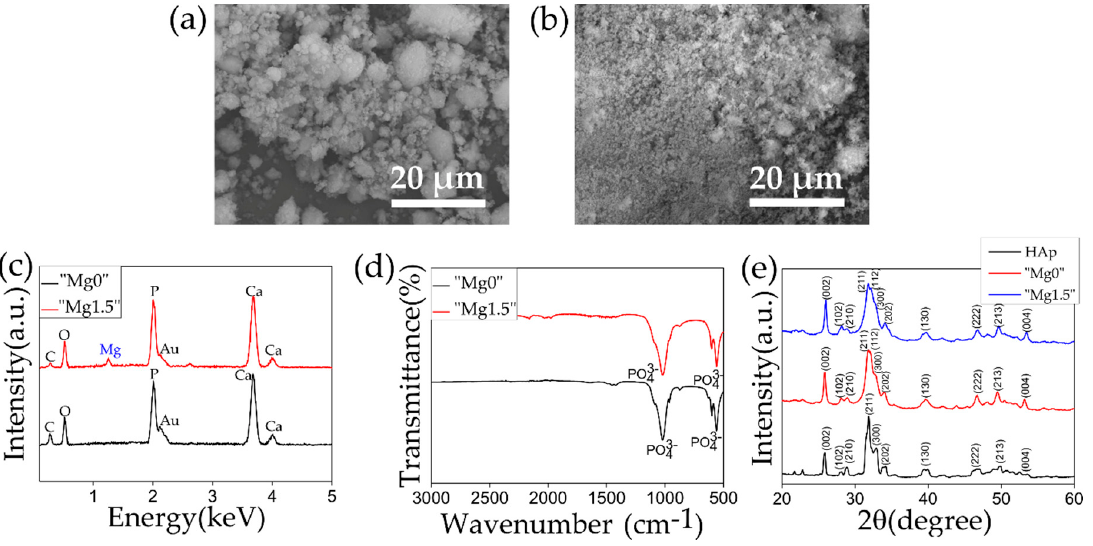
Figure 2. SEM images of ( a ) “Mg0” and ( b ) “Mg1.5” particles. ( c ) EDX and ( d ) FTIR plots comparing properties of “Mg0” and “Mg1.5” particles. ( e ) XRD plots comparing properties of “Mg0” and “Mg1.5” particles with commercially obtained HAp.